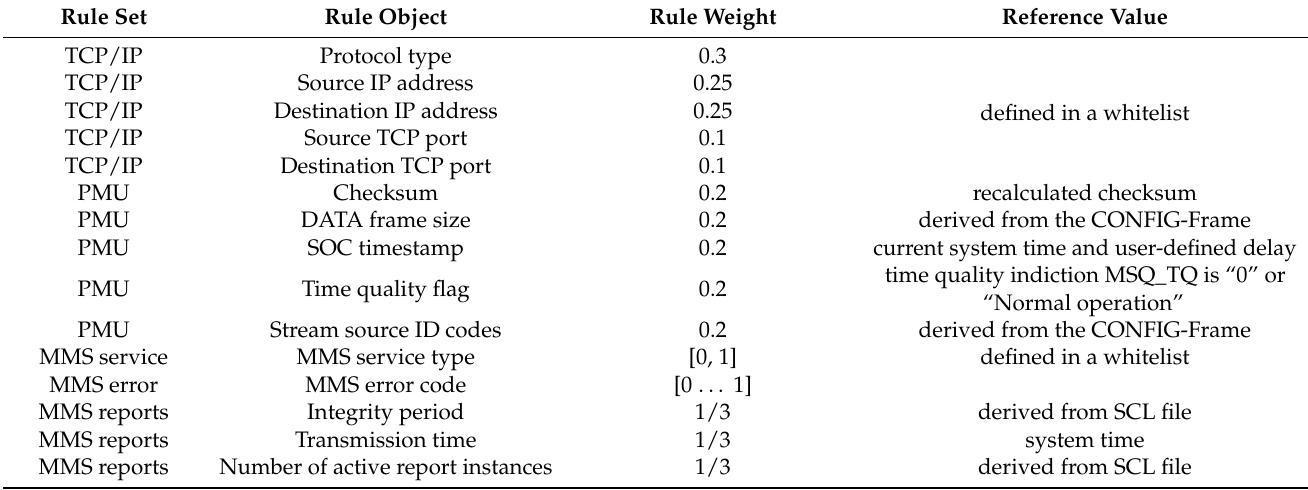
Table 1. Rule overview of the specification-based